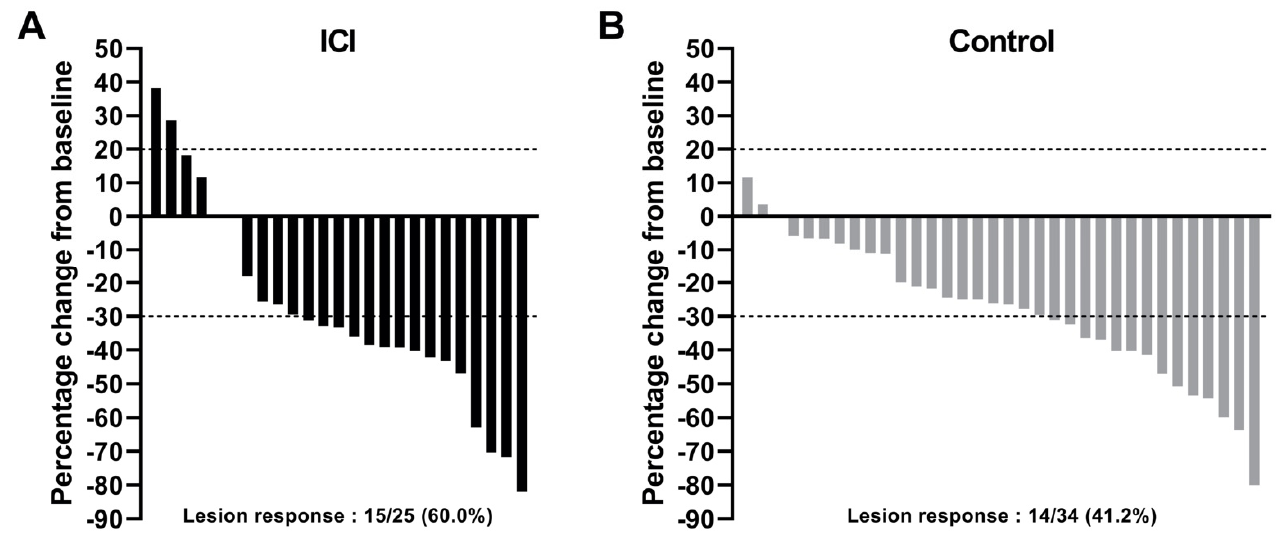
Figure 2. Waterfall plot of change in target lesion size between baseline and preoperative imaging in the ICI ( A ) or control ( B ) group. Lesion size refers to the largest diameter measured on CT-scan in the axial plane. ICI: received preoperative immune checkpoint inhibitors; control group: received standard pre-operative chemotherapy as part of an induction treat- ment.